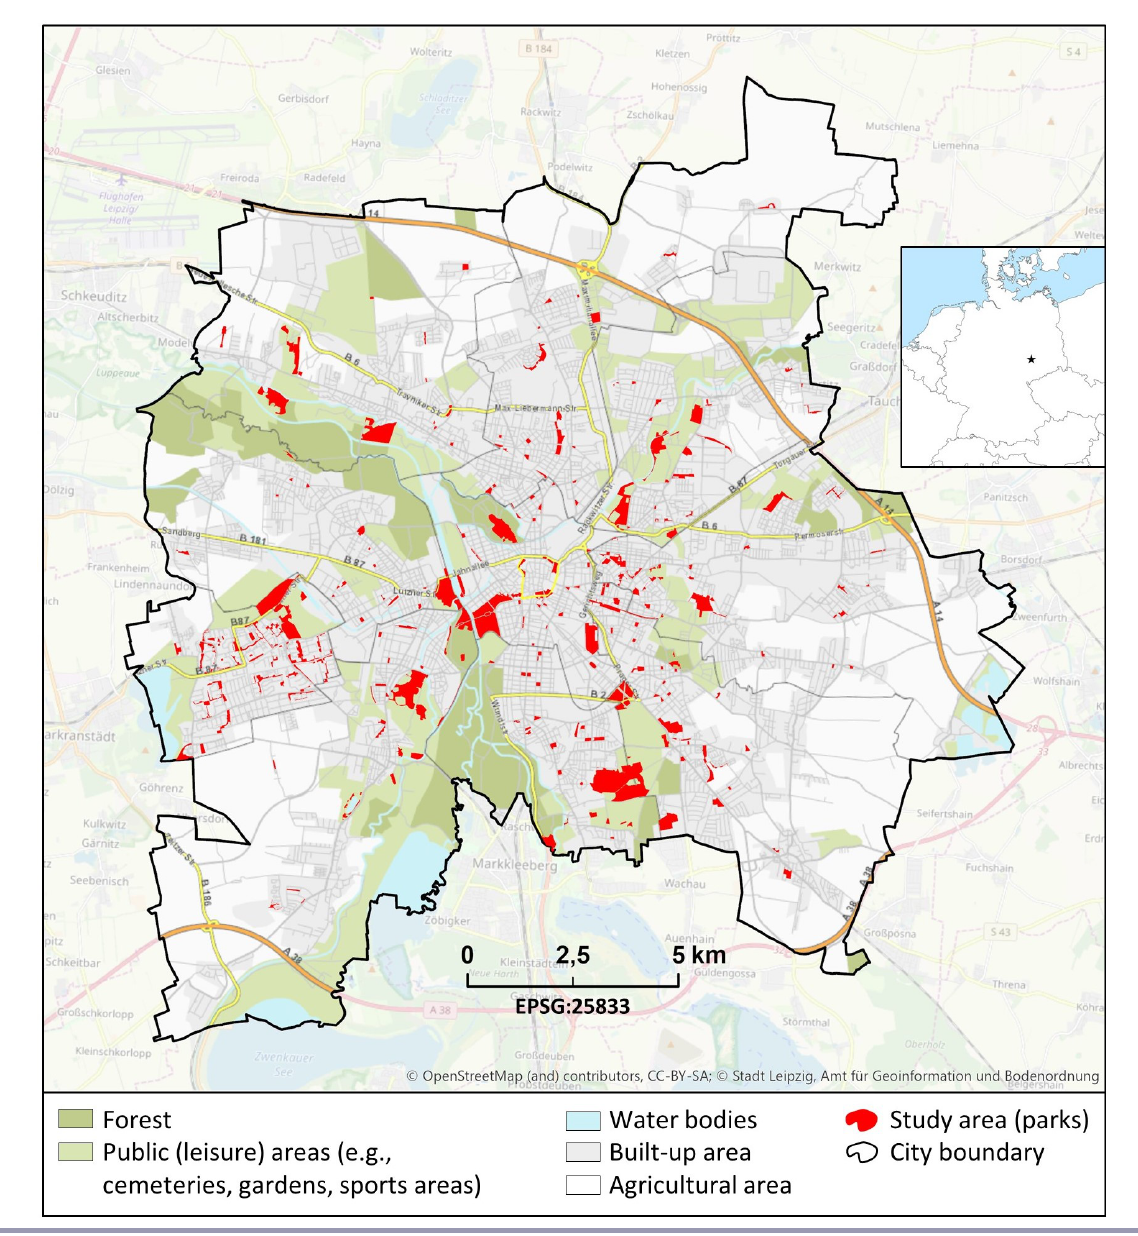
Fig. 2 . Study area, City of Leipzig, with distribution of selected green spaces (parks). Base map